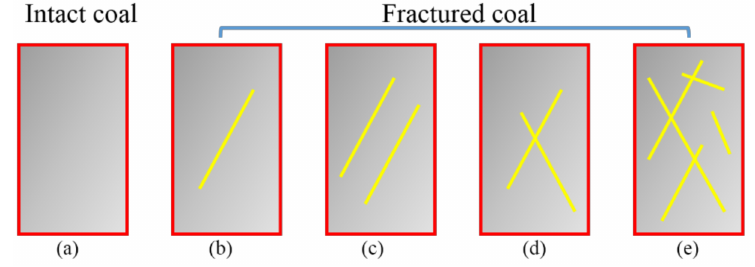
Figure 1. Backbone fracture patterns. ( a ) NF, ( b ) MDF, ( c ) PDF, ( d ) SCF, ( e )